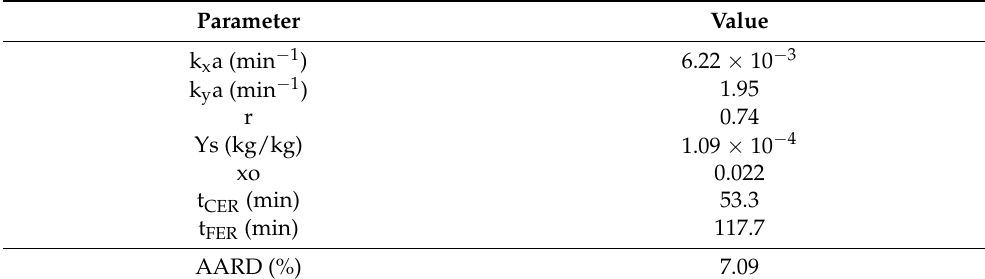
Table 3. BIC Model Parameters Obtained for the sc-CO 2 Extraction of Paulownia bark at 30 MPa and 45 ◦ C.